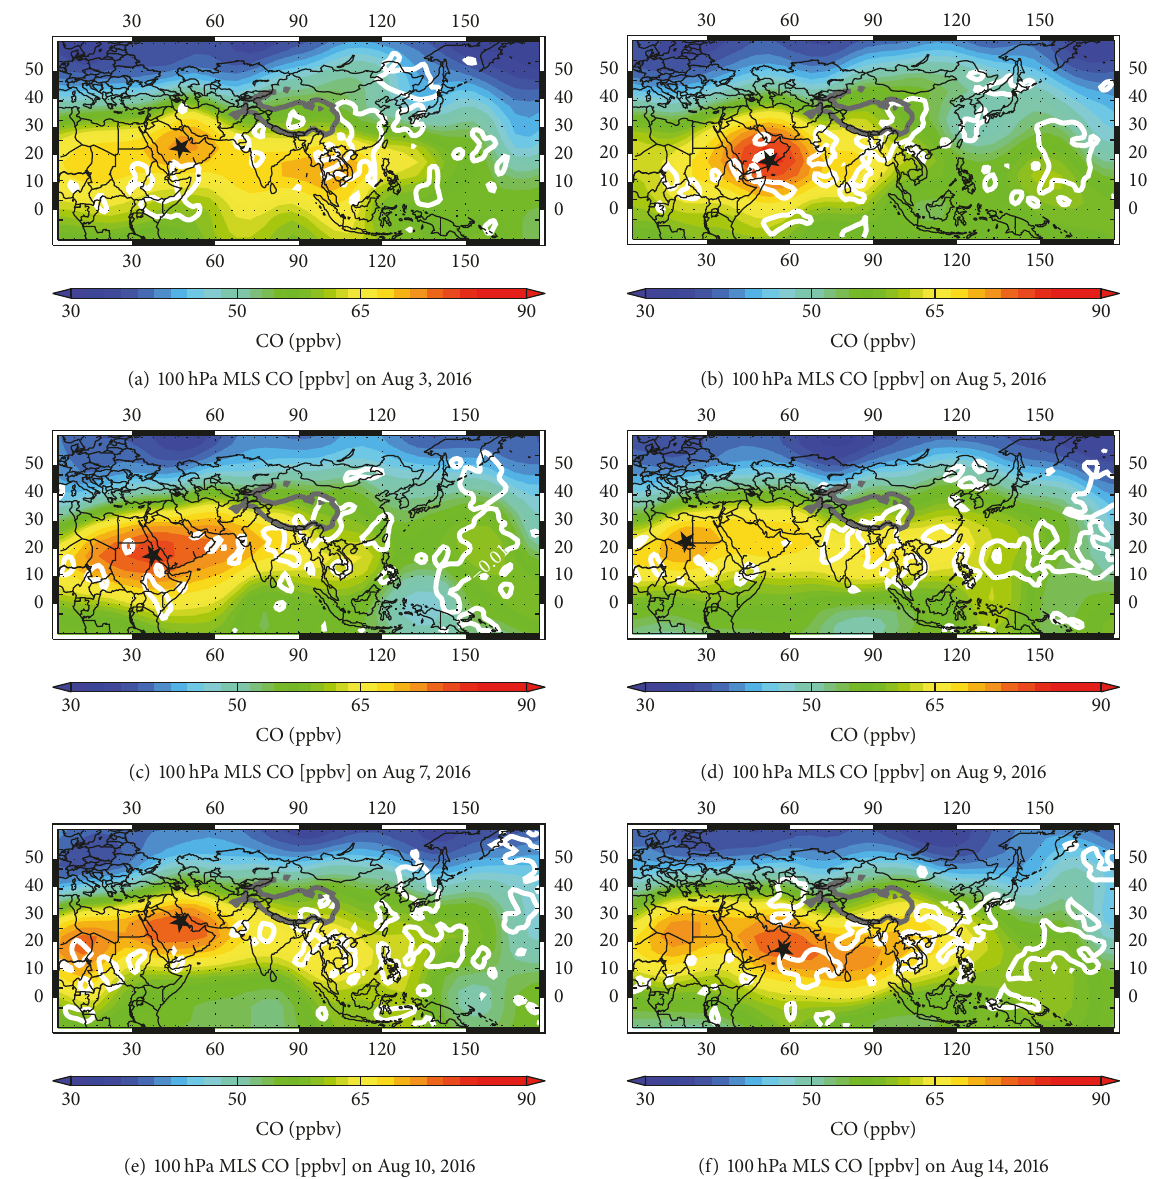
Figure 3: Daily maps of MLS CO mixing ratio at 100 hPa (color shading) on (a) Aug 3, (b) Aug 5, (c) Aug 7, (d) Aug 9, (e) Aug 10, and (f) Aug 14, 2016. The thick gray lines are the 600hPa contour of surface pressure, indicating the location of the Tibetan Plateau (TP). The regions inside of the white contours represent areas with upward transport (vertical velocity less than − 1Pa/s) at 100hPa. The five-pointed star indicates maximum of CO mixing ratio in the Asian summer monsoon